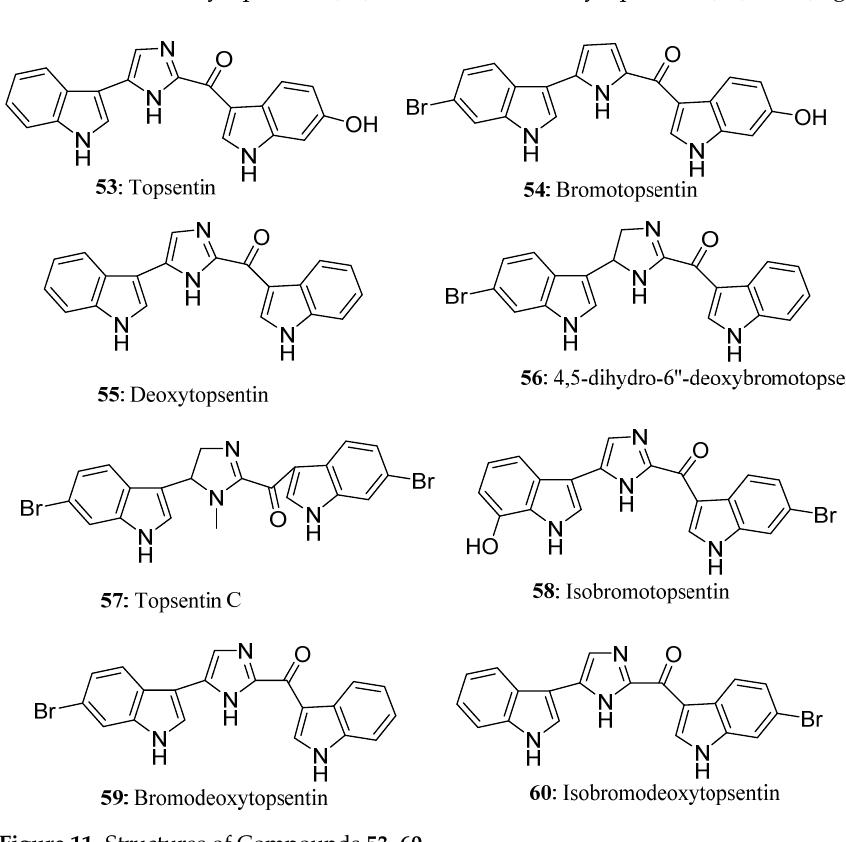
Figure 11. Structures of Compounds 53 – 60 .